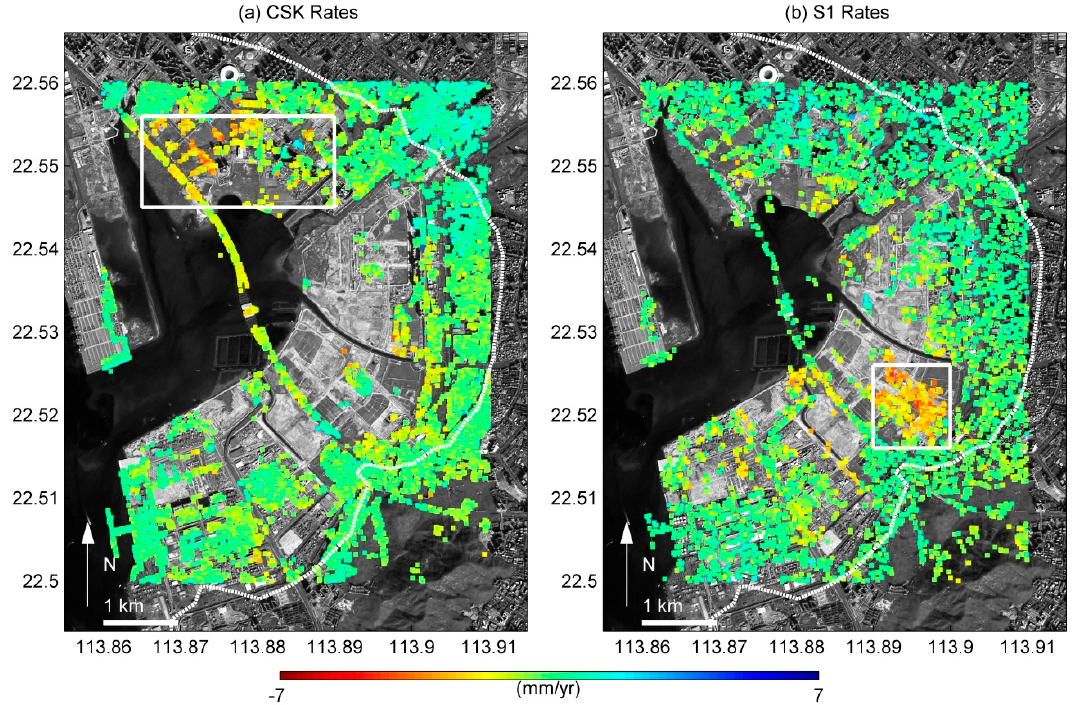
Figure 7. ( a ) CSK and ( b ) S1 mean rates in Qianhai area. The white dashed line is the coastline in 1979. Background is a SPOT-5 image collected on 30 November 2013. Subsidence is outlined by white rectangle.